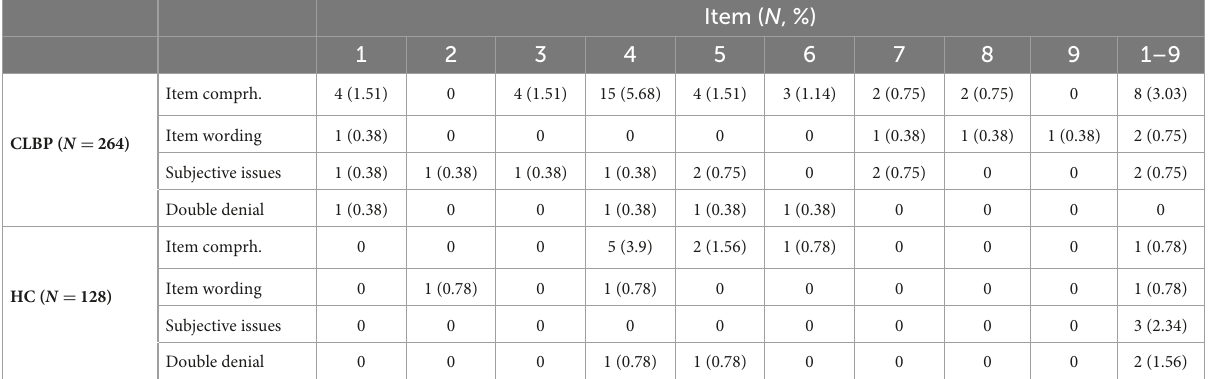
TABLE 2 Comprehensibility of the FreBAQ-S between groups.